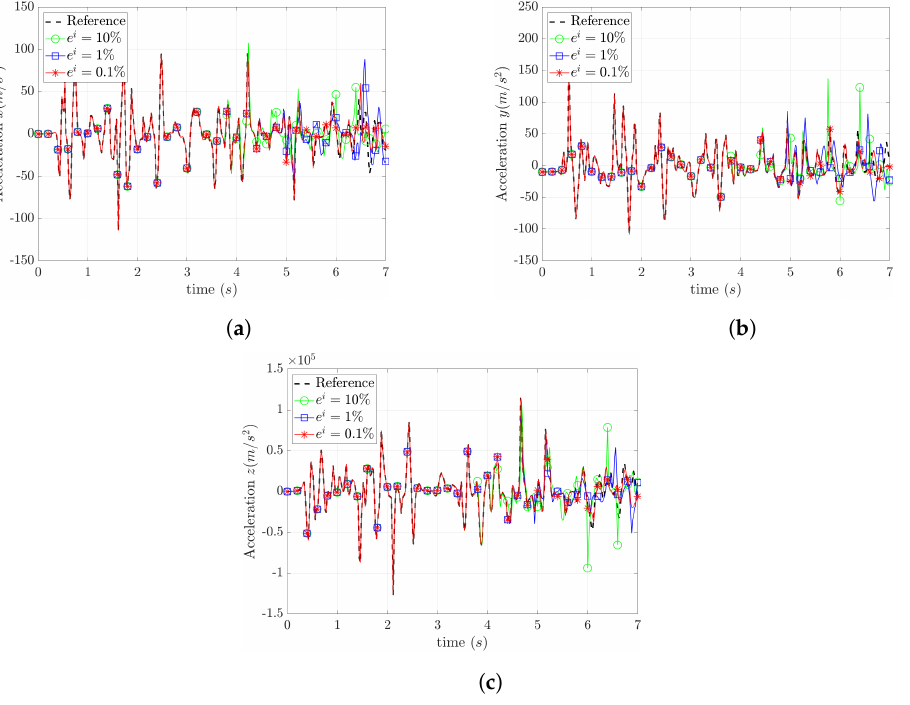
Figure 7. The x , y , and z accelerations of node A for the error tolerance e i = 10%,1%, and 0.1%. ( a ) Acceleration x of node A ; ( b ) acceleration y of node A ; ( c ) acceleration z of node A